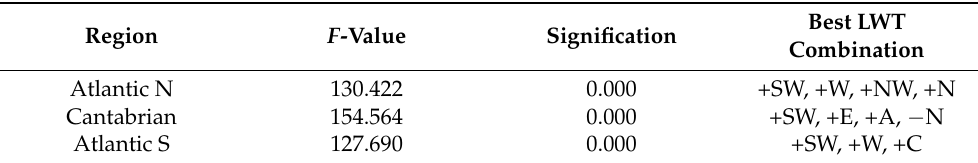
Table 3. F -values and significance from an ANOVA procedure to determine whether the mean values of the Principal Component scores within the synoptic categories were significantly different, and selected circulation pattern on each region.